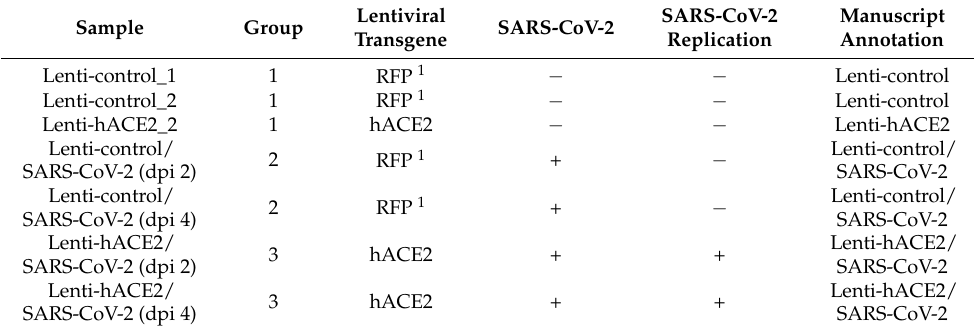
Table 2. The infection